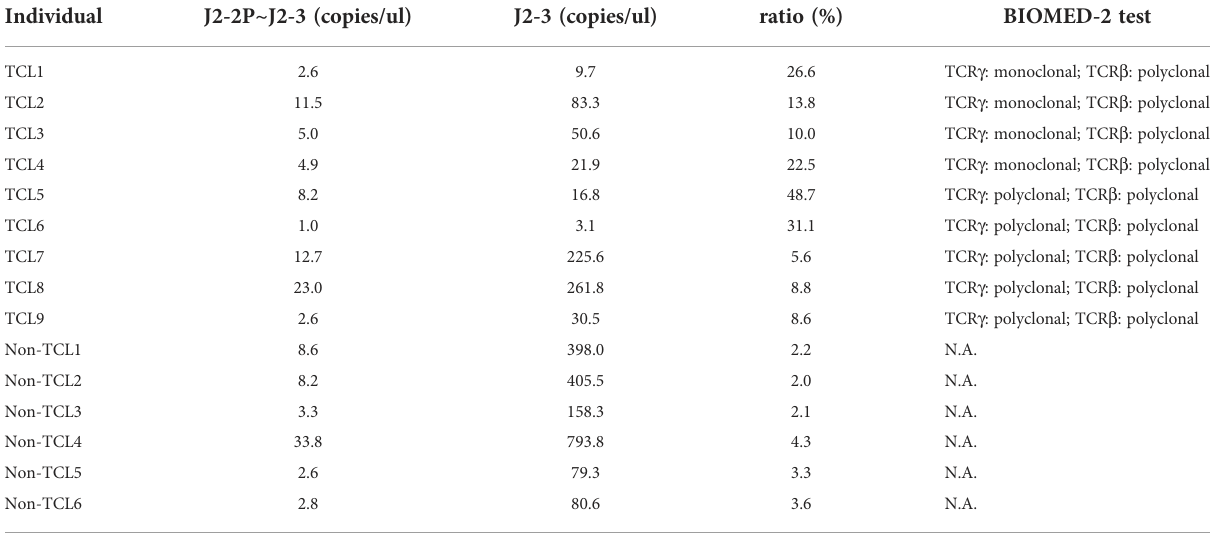
TABLE 2 Concentrations of the J2-2P~J2-3 and the J2-3 sequences measured by digital PCR and the ratios (J2-2P~J2-3 to J2-3) for TCL and non-TCL patients.